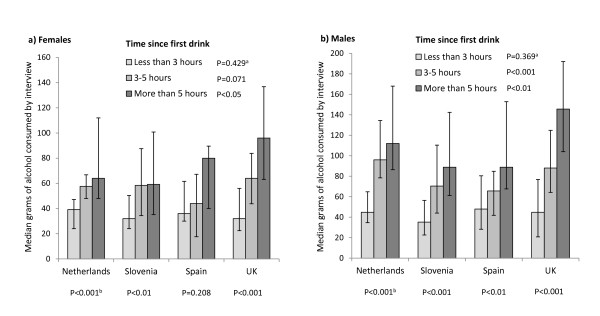
Median grams of alcohol (and interquartile range) consumed by interview, by time since first drink. Analysis uses Kruskal Wallis Test. aP between nationalities across time periods; bP between time periods within locations.